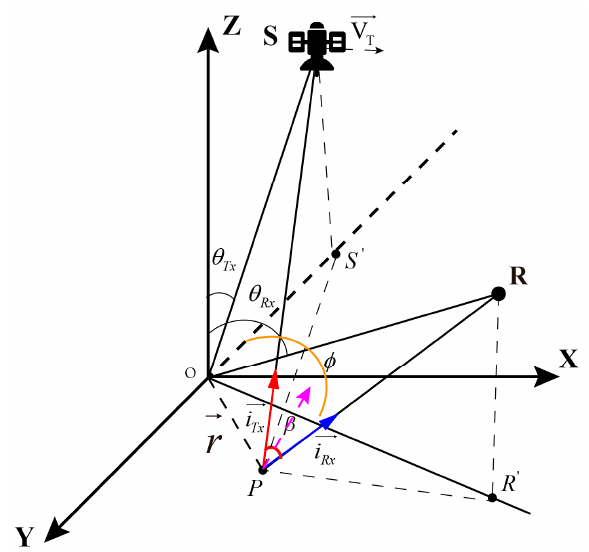
Figure 1. GNSS-based Bistatic SAR geometry—a ground-based stationary receiver.